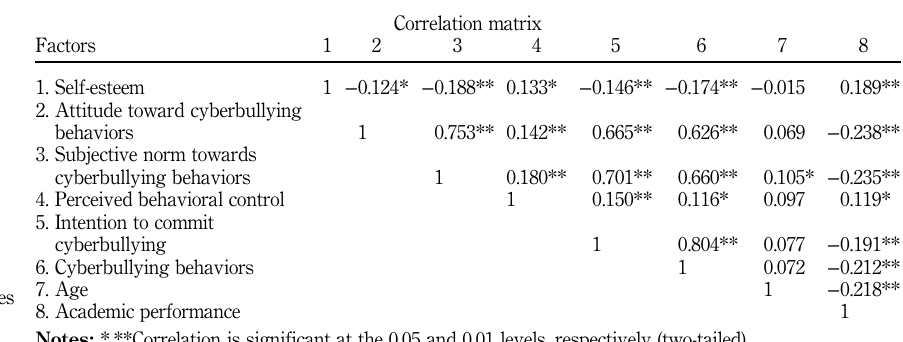
independent variables related to cyberbullying